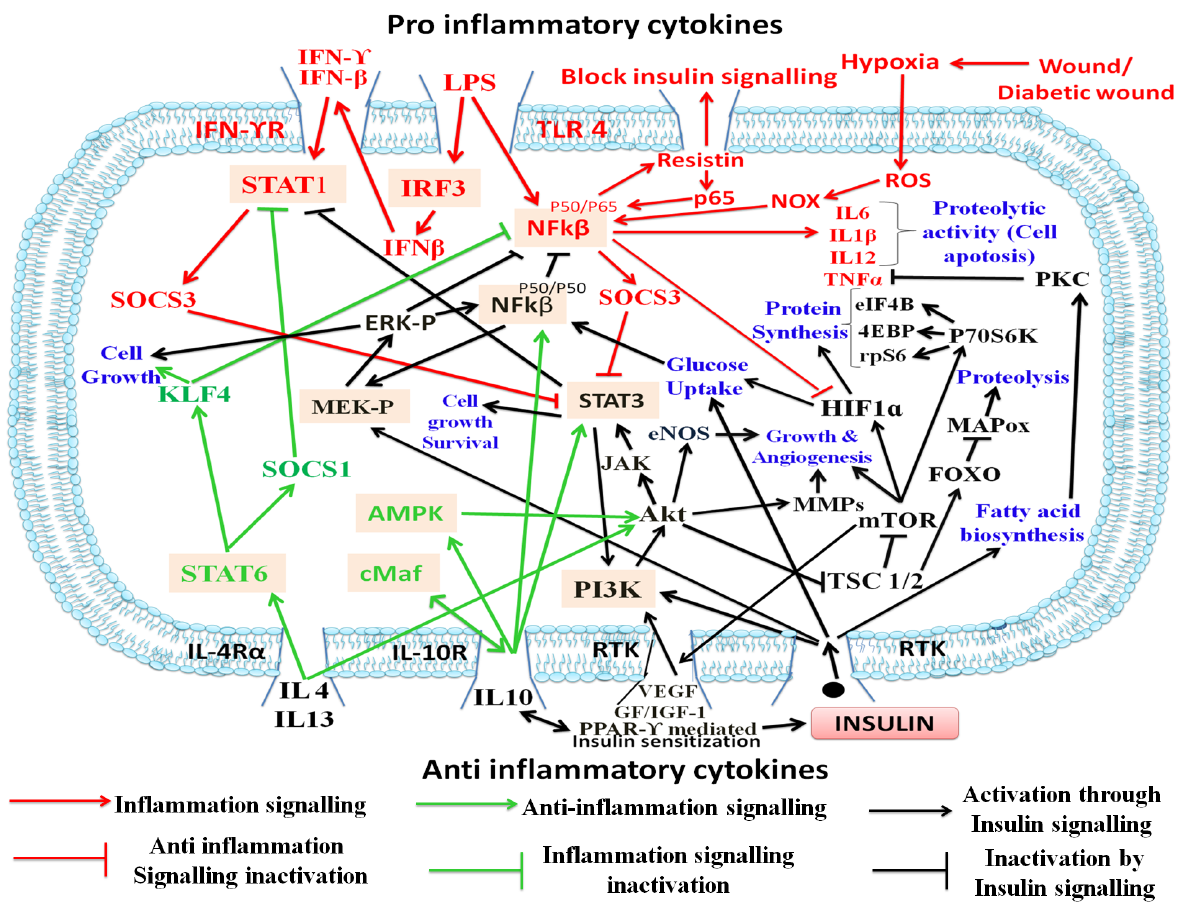
Figure 3: Molecular pathway for transition of macrophages i.e. from the M1 to M2 phase. IFN ϒ and TNF ɑ generation in wounds activates NFk β, IRF-3, STAT1 which helps in secretion of IL-10, IL-1β, IL-12, TNF-α, STAT1 and NFkβ P50/P65 , responsible for inflammation. The transition of M1 to M2 macrophages is necessary for wound healing. IL-4, IL-13, IL-10, IGF, VEGF and insulin can activate PKC, HIF-α, STAT3, NFkβ P50/P50 etc cytokines in order to produce an anti-inflammatory